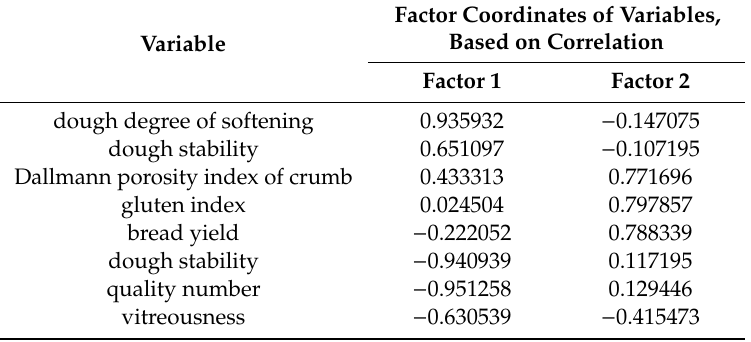
Table 6. Value of principal components coefficients.